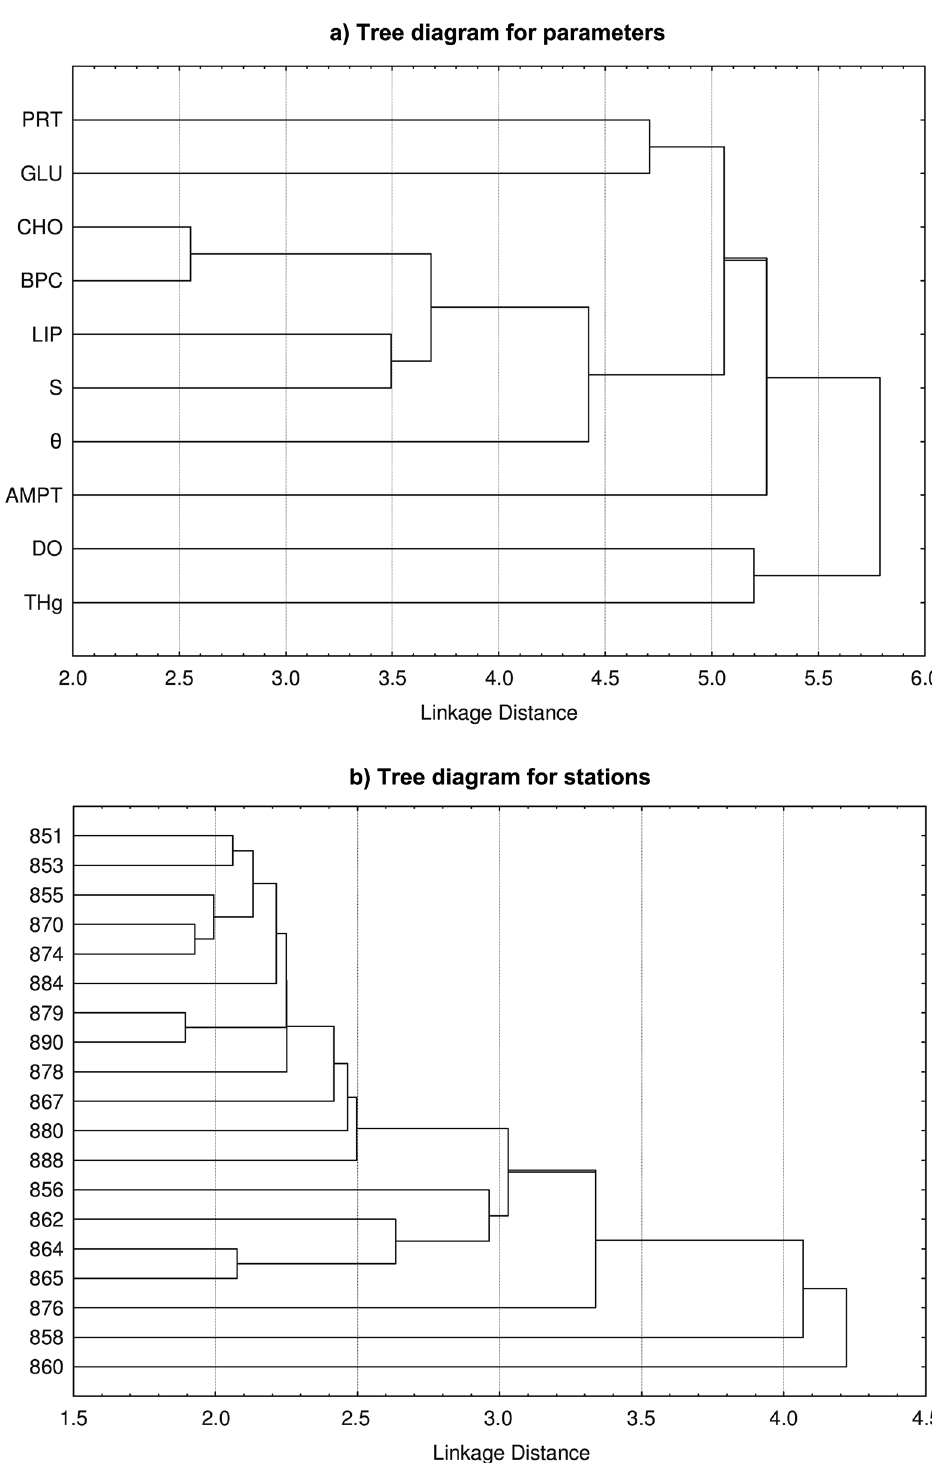
Fig 5. Grouping of parameters and stations in the Eastern Mediterranean abyss. The analysis is performed on parameters (a) and stations (b) of MSM 13 – 2 based on all available standardized physical and biogeochemical parameters. The grouping is based on a tree clustering algorithm with single linkage amalgamation rule.